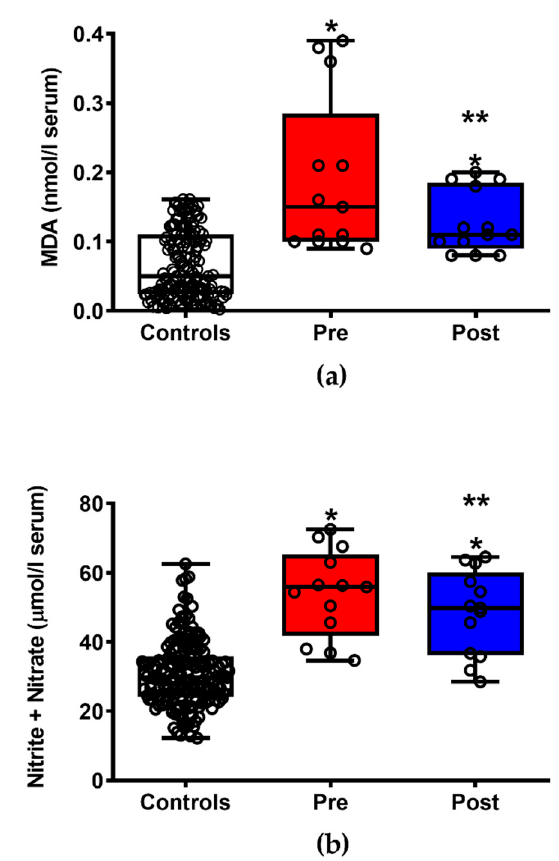
Figure 2. Box plots reporting minimum, maximum, median, 25% and 75% percentiles of the serum concentrations of lipid peroxidation end product (MDA, ( a )) and stable compounds of nitric oxide metabolism (nitrite + nitrate, ( b )) in 13 patients with ALS before (Pre) and after (Post) ILB ® treatment. The values measured in a group of 163 healthy controls are also reported. ( ○ ) Open circles are the values of metabolites in each subject enrolled in the study. Means ± S.D. of MDA in controls, patients with ALS before (Pre) and after (Post) ILB ® treatment were, respectively, 0.066 ± 0.048, 0.190 ± 0.114 and 0.128 ± 0.046 µmol/L serum. Means ± S.D. of nitrite + nitrate in controls, patients with ALS before (Pre) and after (Post) ILB ® treatment were, respectively, 30.90 ± 9.67, 53.98 ± 12.55 and 48.47 ± 12.25 µmol/L serum. * Significantly different from Controls, p < 0.001. ** Significantly different from Pre, p < 0.05.